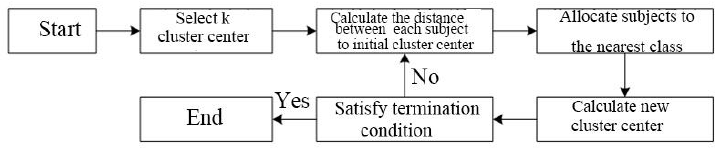
Figure 4: The flow of K-means